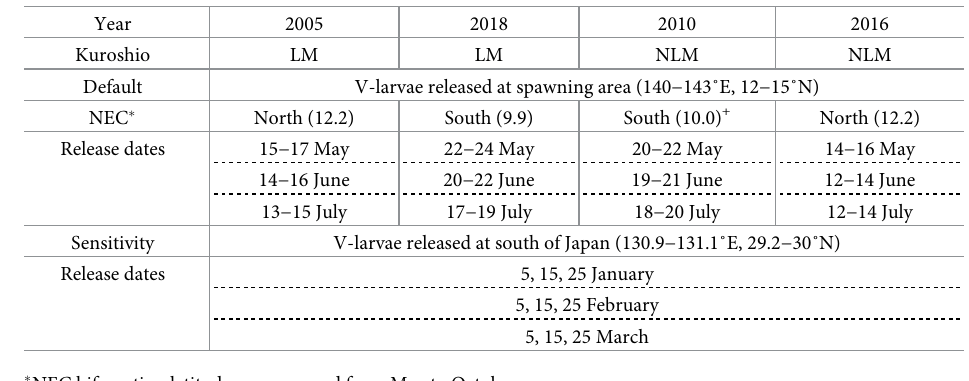
Table 1. List of experiments and the corresponding oceanic conditions used in each simulation for the main experiments on the effect of the presence of the Kuroshio large meander and swimming sensitivity experiments. For the meander experiments, release dates were 2–4 days before the new moon of each month during the spawning period in the selected years, and for the sensitivity cases, v-larvae were released in the Kuroshio south of Japan during the peak recruitment season. The numbers listed in the parenthesis of the North Equatorial Current (NEC) region are the mean NEC bifurcation latitudes. Both Kuroshio large meander (LM) and no large meander years (NLM) were used in the